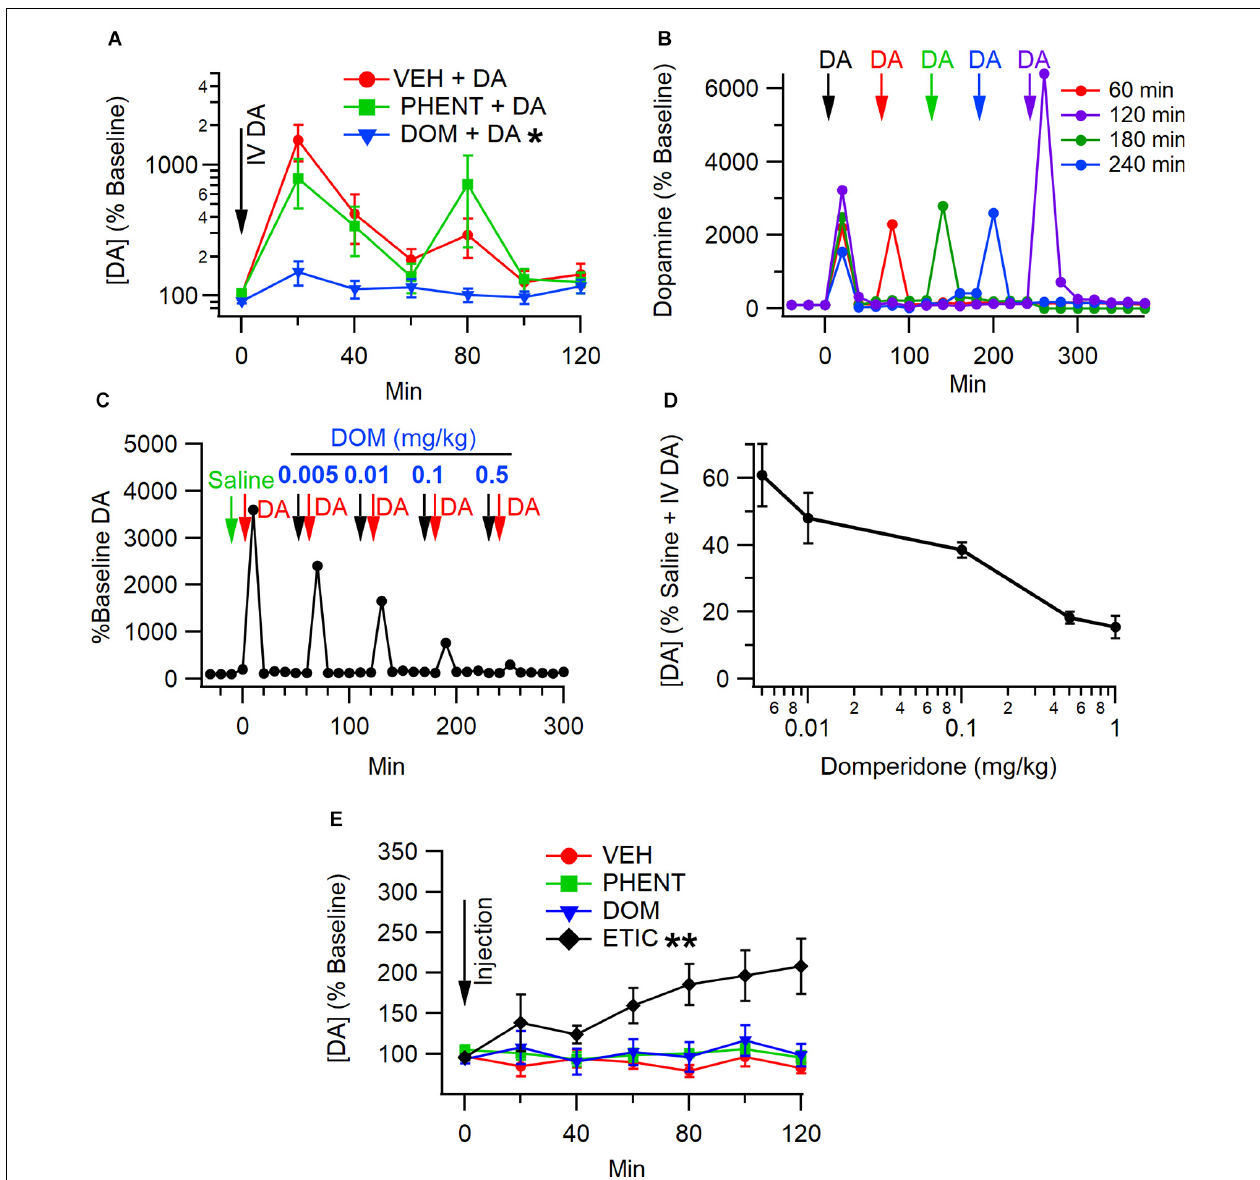
FIGURE 2 | Antagonism of peripheral D2Rs blocks enhancement of NAc DA levels by IV DA. (A) IV administration of DA (1 mg/kg) enhanced DA levels in the NAc in the presence of a vehicle (VEH). In the presence of domperidone (DOM), a peripheral D2R antagonist, the effect of IV DA on NAc DA levels was attenuated, while phentolamine (PHENT) had no effect on NAc DA levels following IV DA. Dose-response for domperidone on IV DA enhancement of NAc DA release. (B) Interval dependency of sequential IV DA injections (1.0 mg/kg). These are four representative experiments at four intervals (60, 120, 180, and 240) showing that